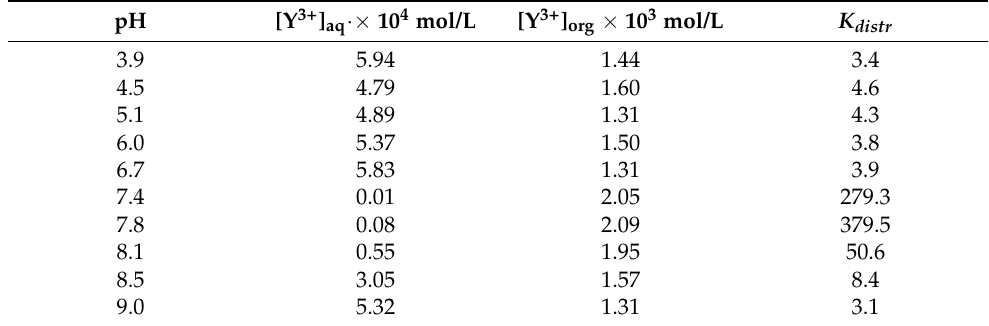
Table 3. The results of the experimental study of yttrium (III) cations recovery to froth pulp in nitrate-chloride medium at the NaCl concentration of 0.01 M.